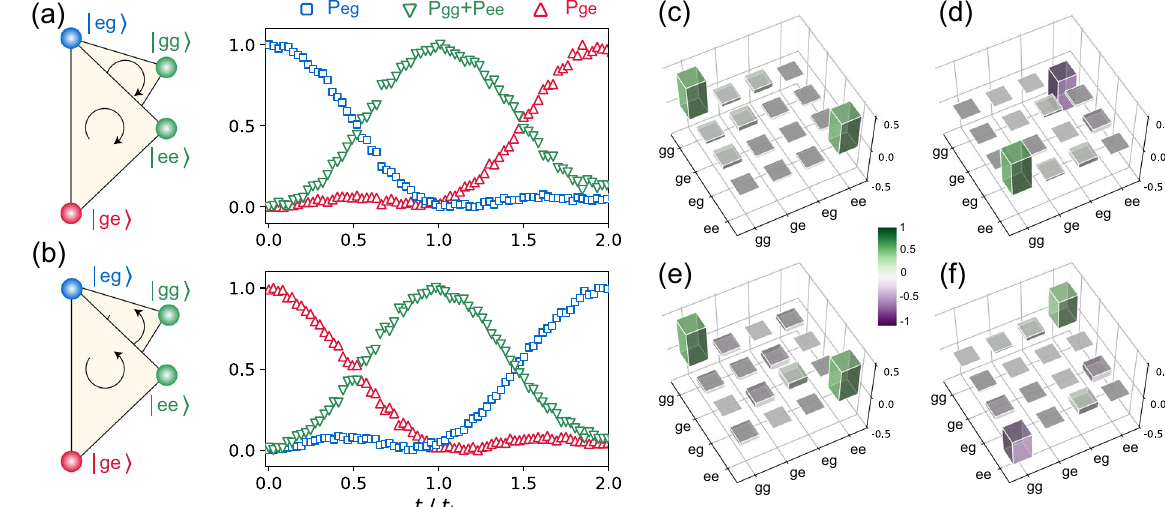
Fig. 4 Generation of entangled states using CCI. a , b The measured populations of P eg , P ge , and P gg + P ee . The non-entangled states eg j i and ge j i in a and b evolve into the entangled states of gg j i ± i ee j ið Þ = c Real and d imaginary parts of the density matrix for the entangled state of gg j i þ i ee j ið Þ = state tomography. e Real and f imaginary parts for the state of gg j i (cid:2) i ee j ið Þ =